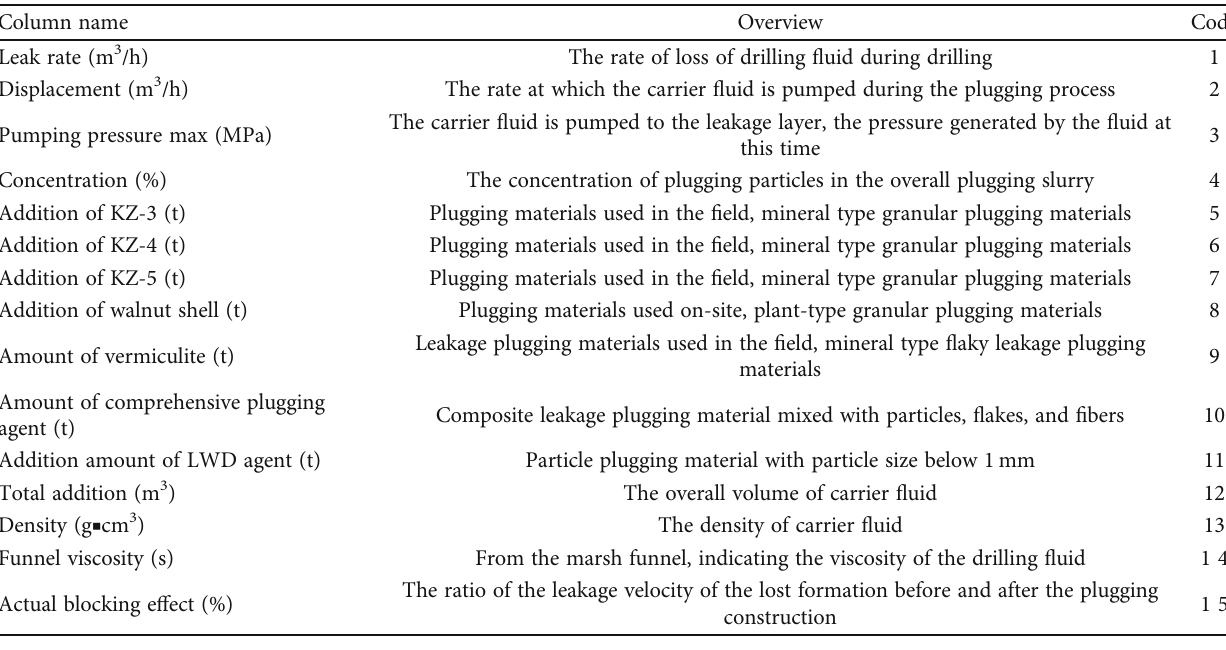
Figure 9: Schematic diagram of the hyperbolic tangent function and sigmoid function. Table 1: Generated code for missing control-related